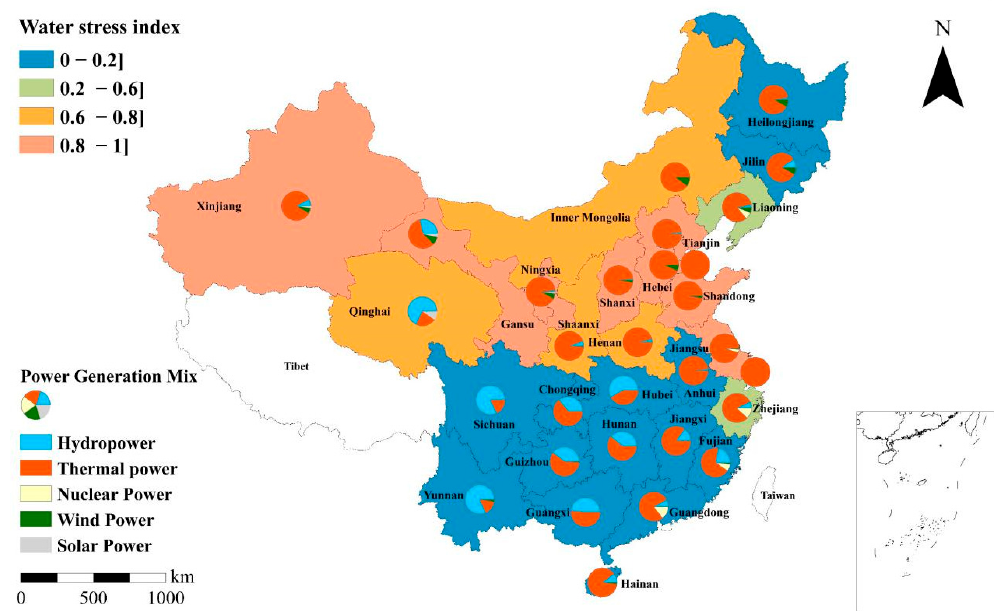
Figure 1. The water stress index (WSI) and electricity generation mix of each province in 2014.